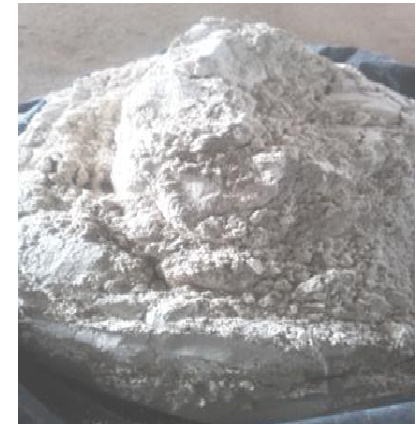
Figure 1: Periwinkle Shells (Ps) Figure 2: Pulverized Periwinkle Shell